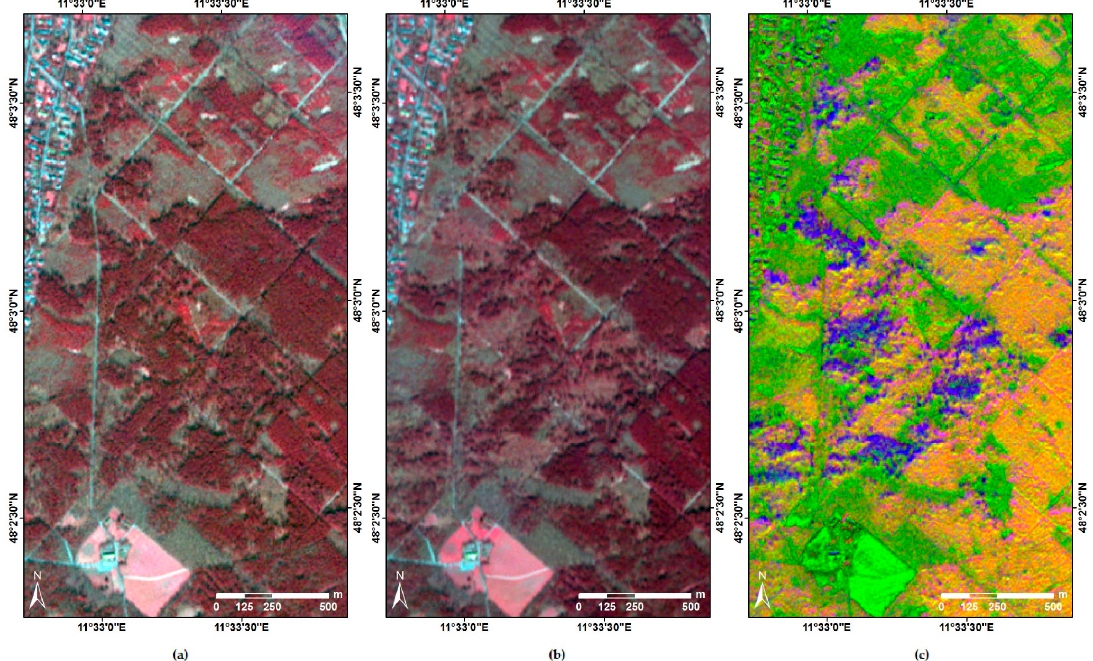
Figure 6. Detail of false color composite (band combination: near infrared—red—green) pre-storm RapidEye scene ( a ); post-storm RapidEye scene ( b ) and pixel-based change detection result based on RapidEye data ( c ) for Munich South . Windthrow areas appear in